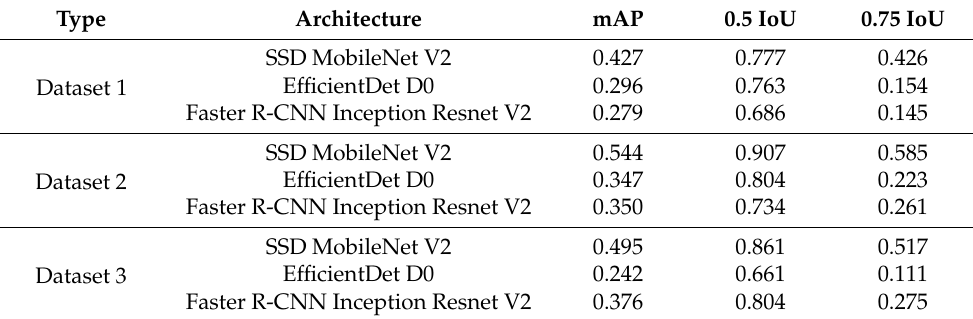
Table 5. The object detection evaluation on the ACF